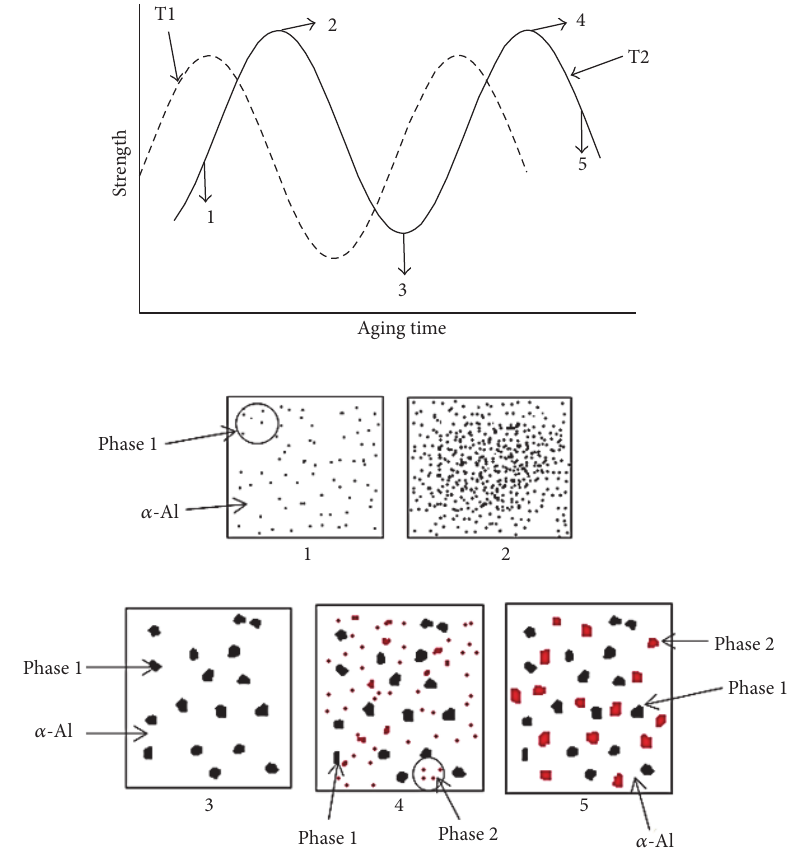
Figure 8: Schematic diagrams showing the possible precipitation, dissolution, and coarsening of the age hardening phases during the course of